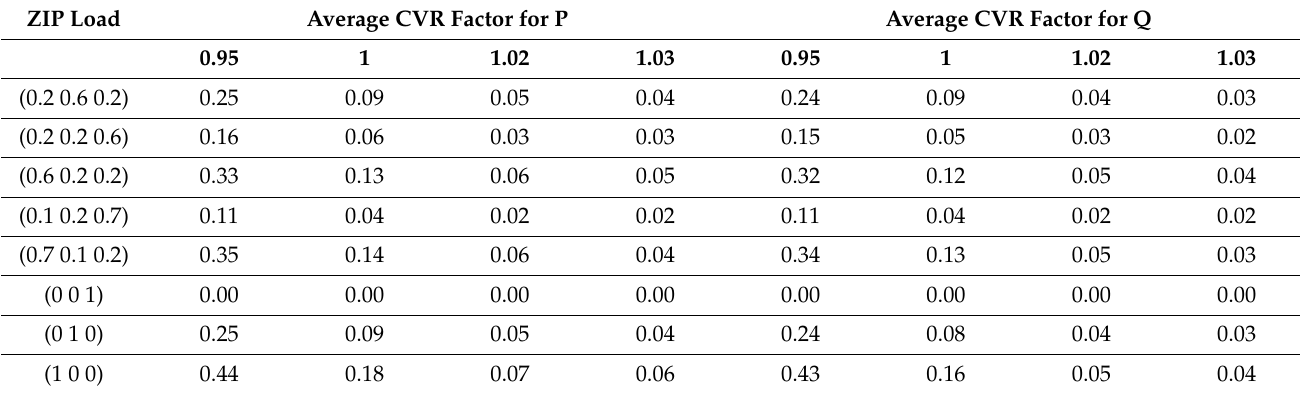
Table 5. Average CVR factor obtained using power captured at load for case